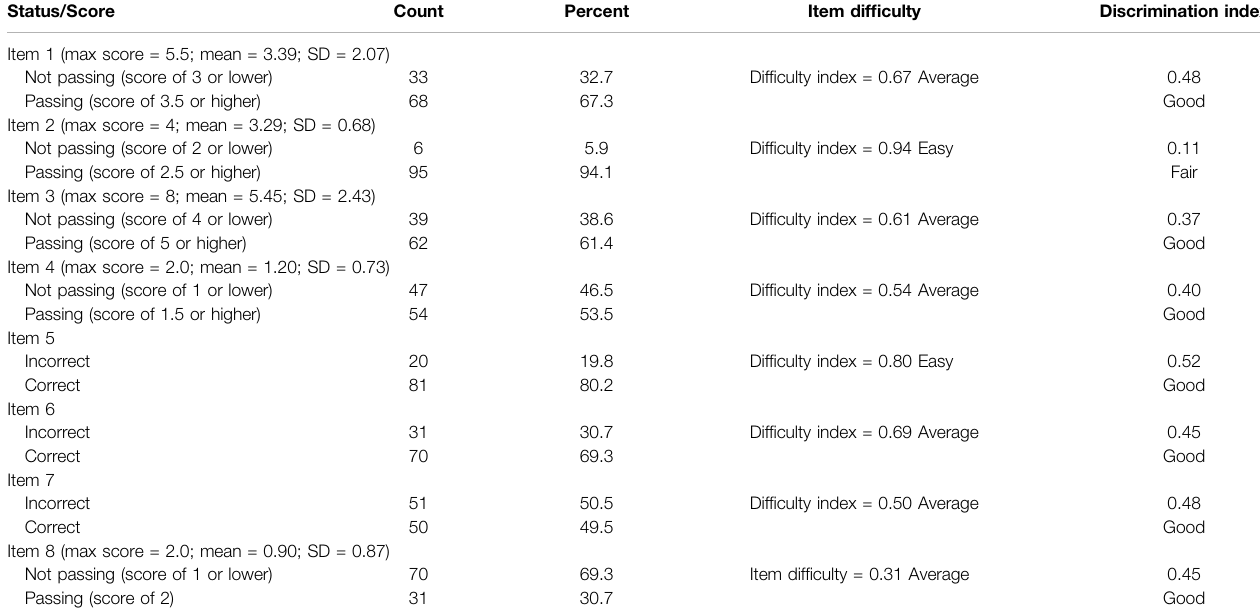
TABLE 7 | Unit 2 item